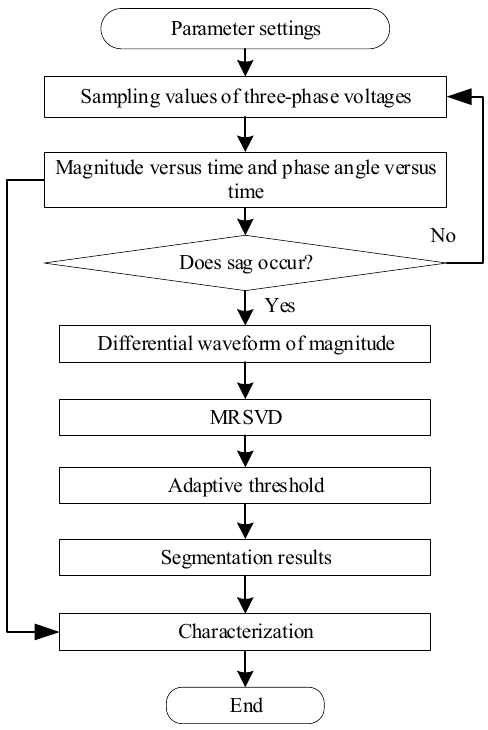
Figure 8. The flow chart for the proposed algorithm.